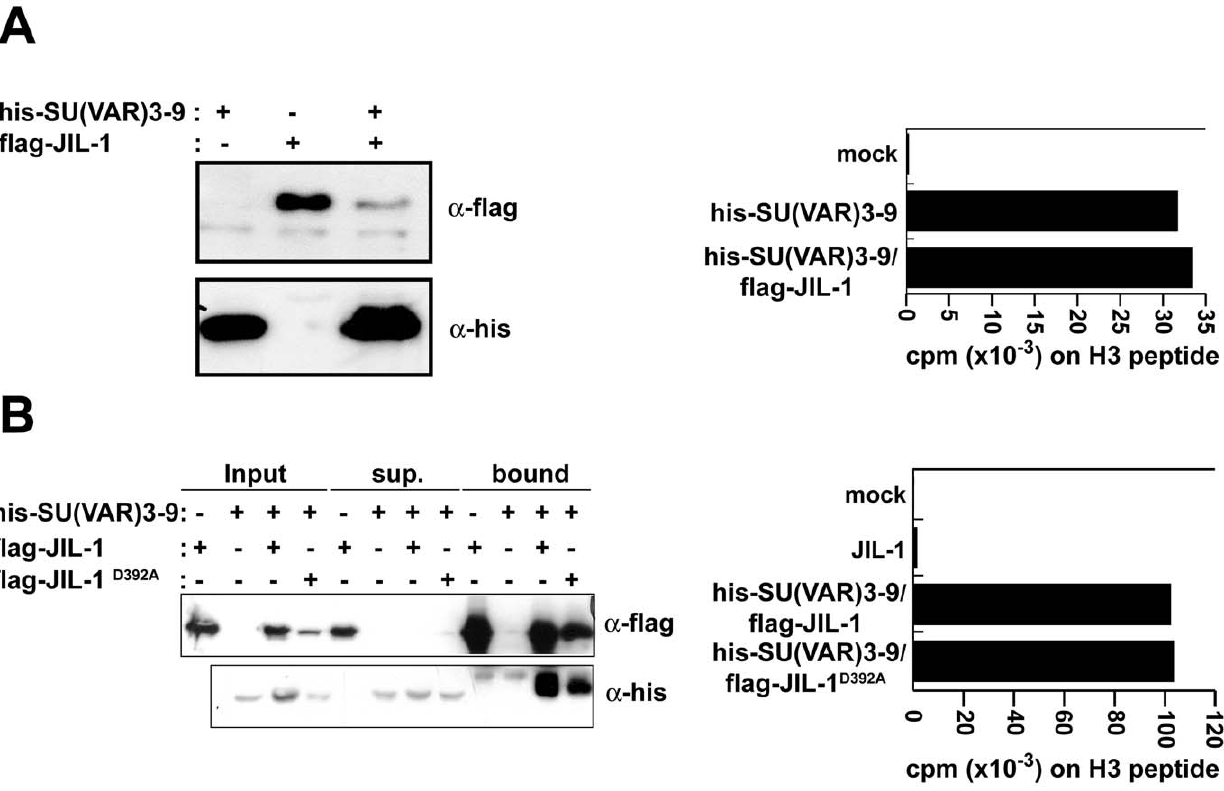
Figure 2. SU(VAR)3–9 and JIL-1 interact invivo . ( A ) Coexpression of JIL-1 and SU(VAR)3–9 in SF9 cells using a baculoviral expression system. left : Western Blot of whole cell Sf9 extract. Proteins were detected using the indicated antibodies. right: Histone methyltransferase assay after co-infection of SF9 cells with flag-JIL-1 and his-SU(VAR)3–9 followed by affinity purification on a Talon TM metal affinity resin. ( B ) Precipitation of JIL-1 from an SF9 cell extract co-purifies active SU(VAR)3–9. left : Western Blot analysis of flag-coimmunoprecipitations using SF9 whole cell extract after co-infection with the indicated viruses. After the Co-IP flag M2-beads were washed and eluted with the flag peptide. 10% of the eluates were separated by SDS PAGE and analyzed by Western blotting using specific antibodies. right: Histone methyltransferase assay after co-infection of SF9 cells with